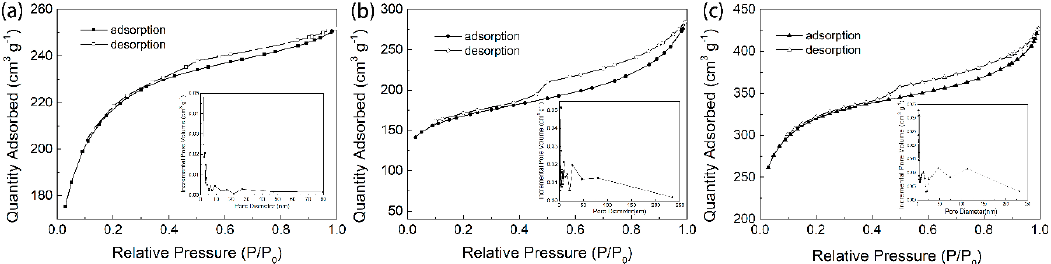
Figure 2. Nitrogen adsorption-desorption isotherms and the Barrette–Joynere–Halenda desorption pore size distribution of (a) GAC 950 , (b) PAC 800 , and (c) PAC 1000. pore size distribution of ( a ) GAC 950 , ( b ) PAC 800 , and ( c ) PAC 1000 .